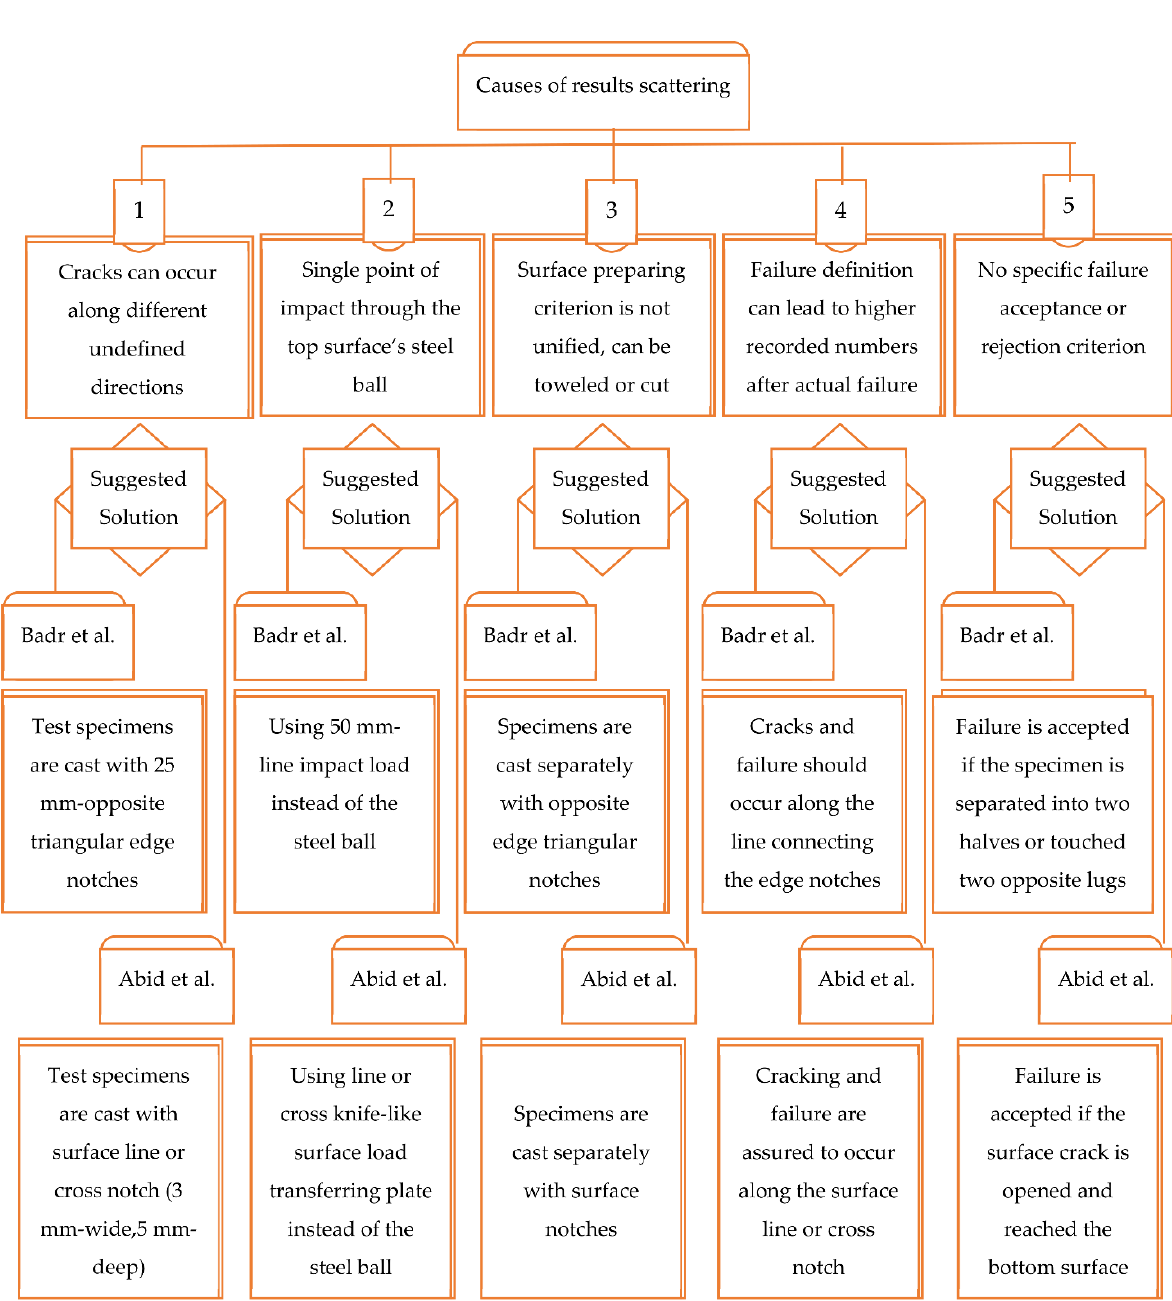
Figure 12. Sources of ACI 544-2R repeated impact scattering of results and suggested modifications by previous